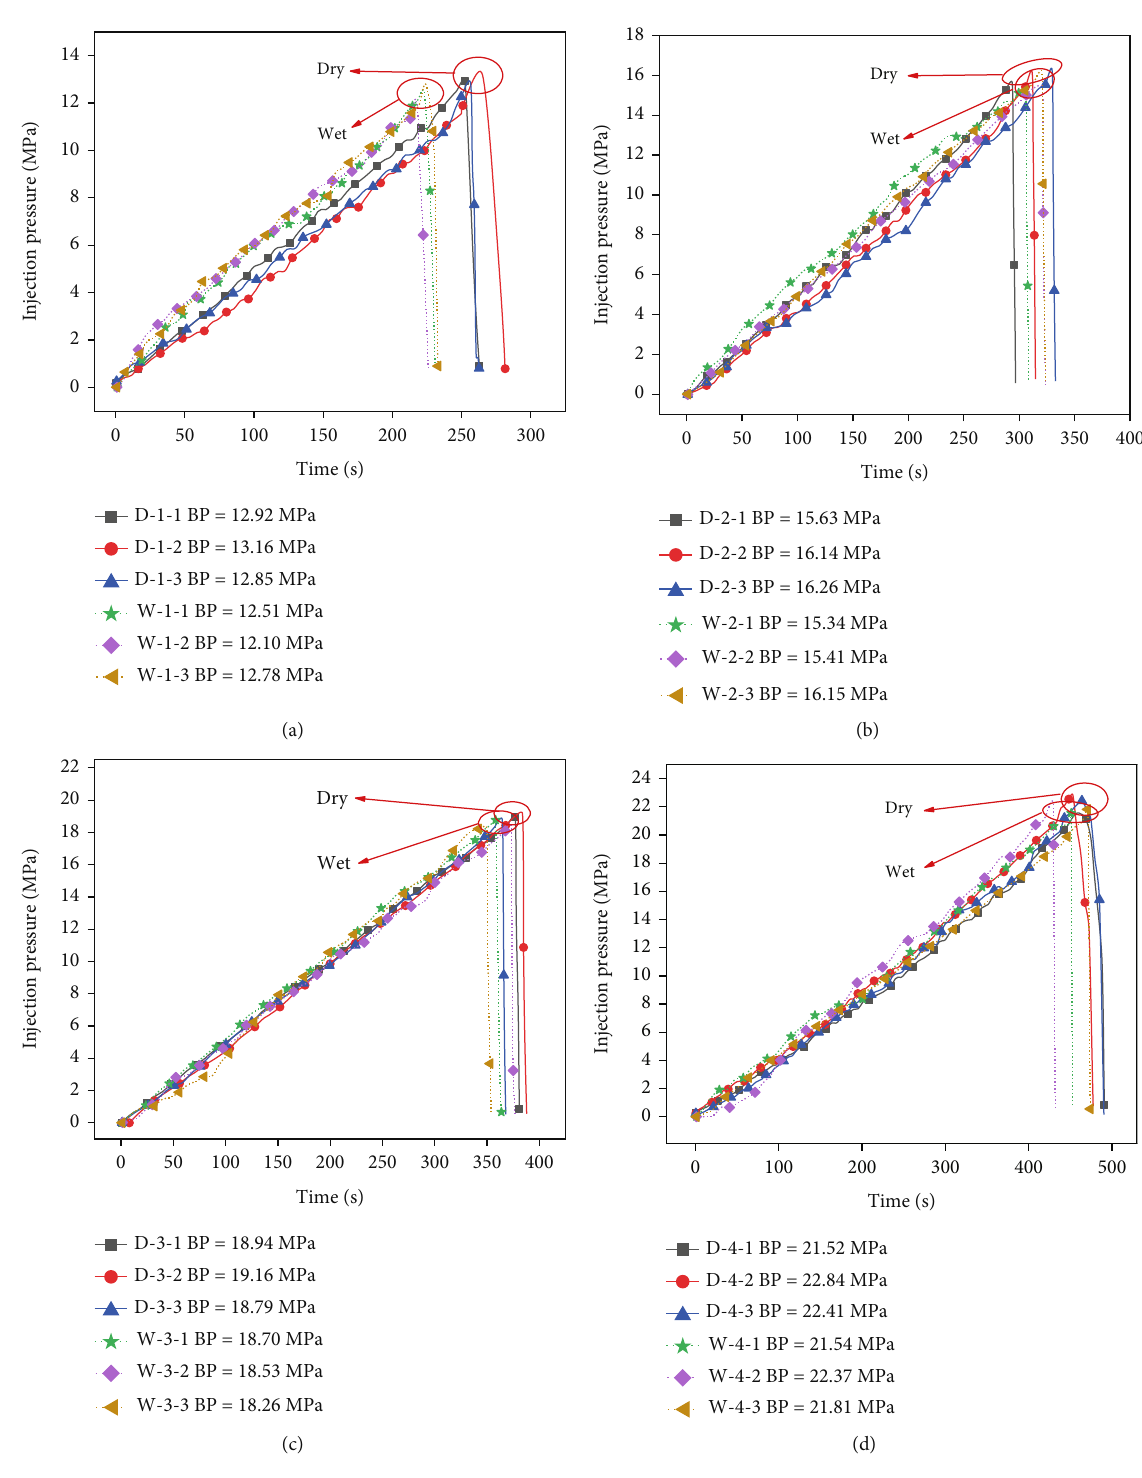
injection under di ff erent con fi ning pressures: 2